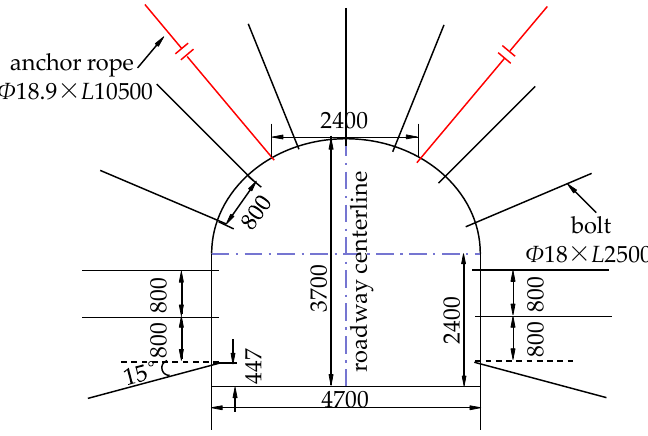
Figure 16. Roadway support design section drawing.